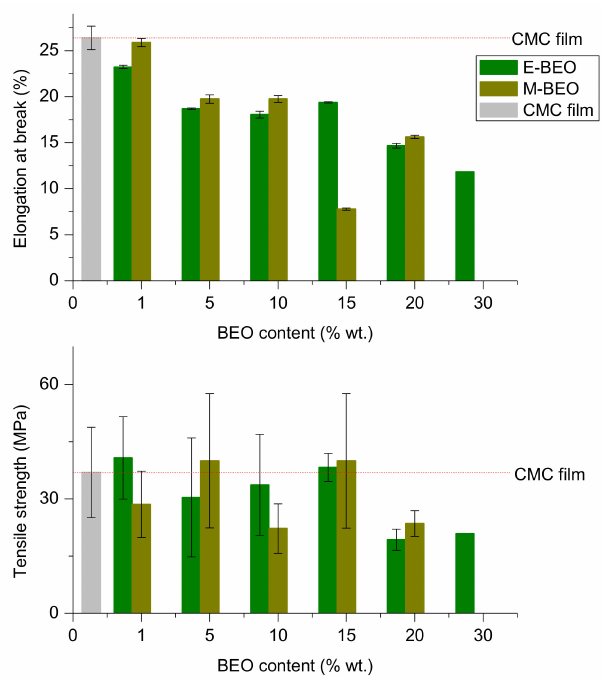
Figure 3. Mechanical properties of CMC films formulated with di ff erent concentrations of BEO: Bottom-tensile strength (MPa), top-elongation at break